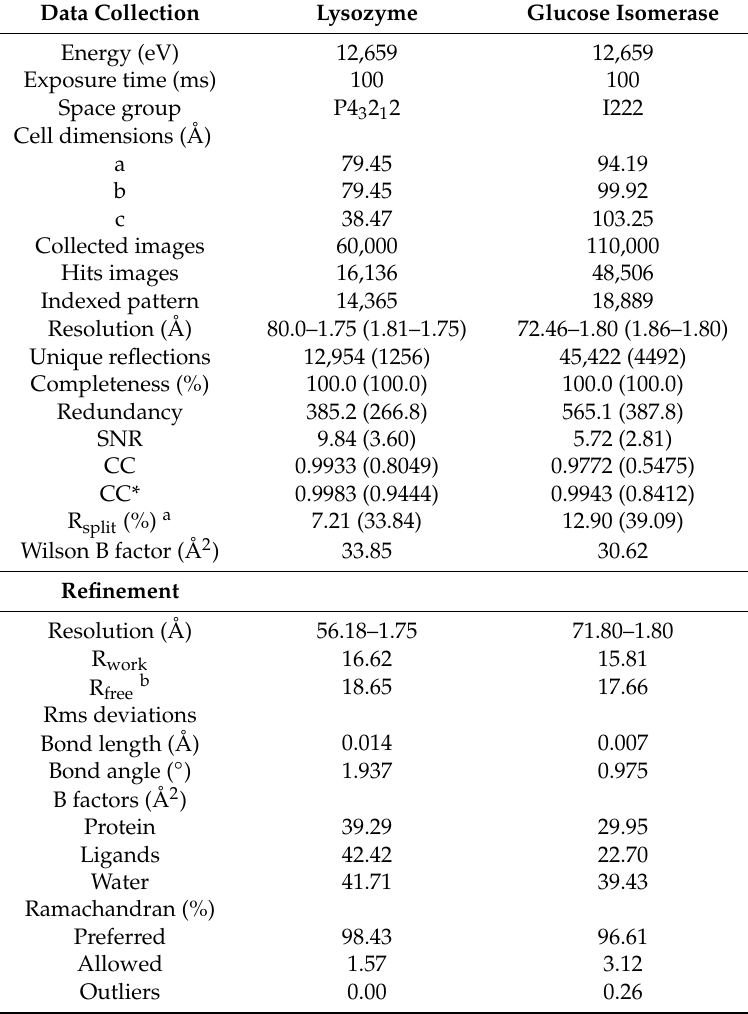
Table 1. Data collection and refinement statistics.